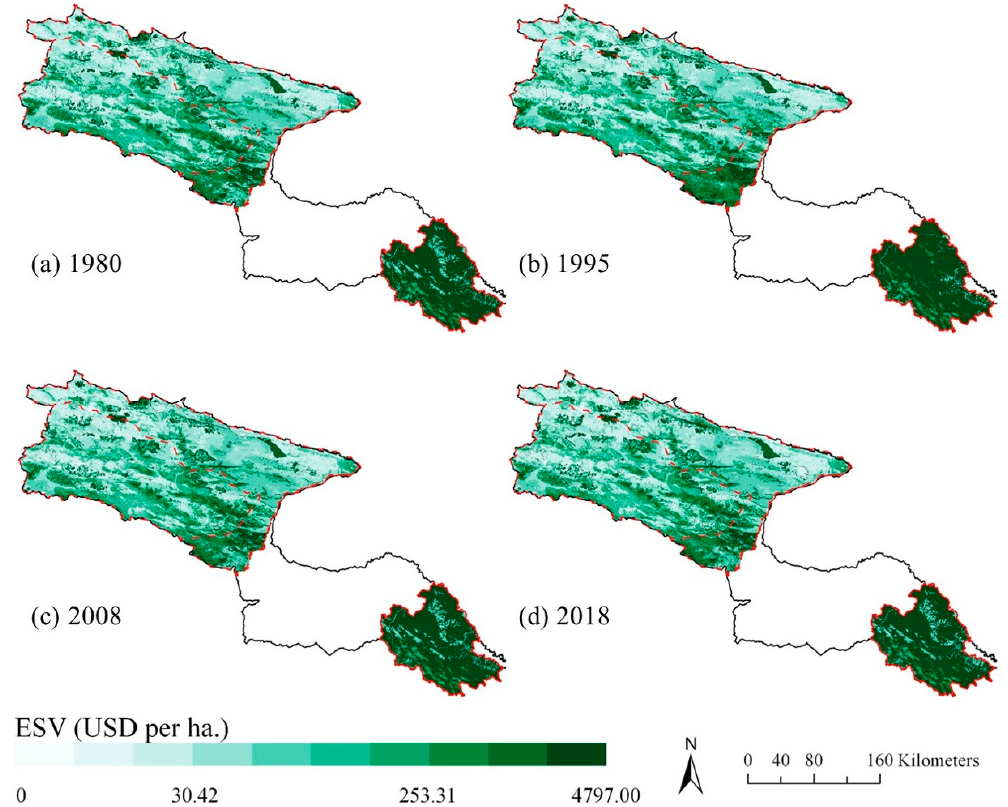
Figure 4. Distribution of the total ecosystem service value (ESV) per unit in the study area for ( a ) 1980, ( b ) 1995, ( c ) 2008, and ( d ) 2018. Table 6. The average ESV per unit in the study area during 1980–2018.